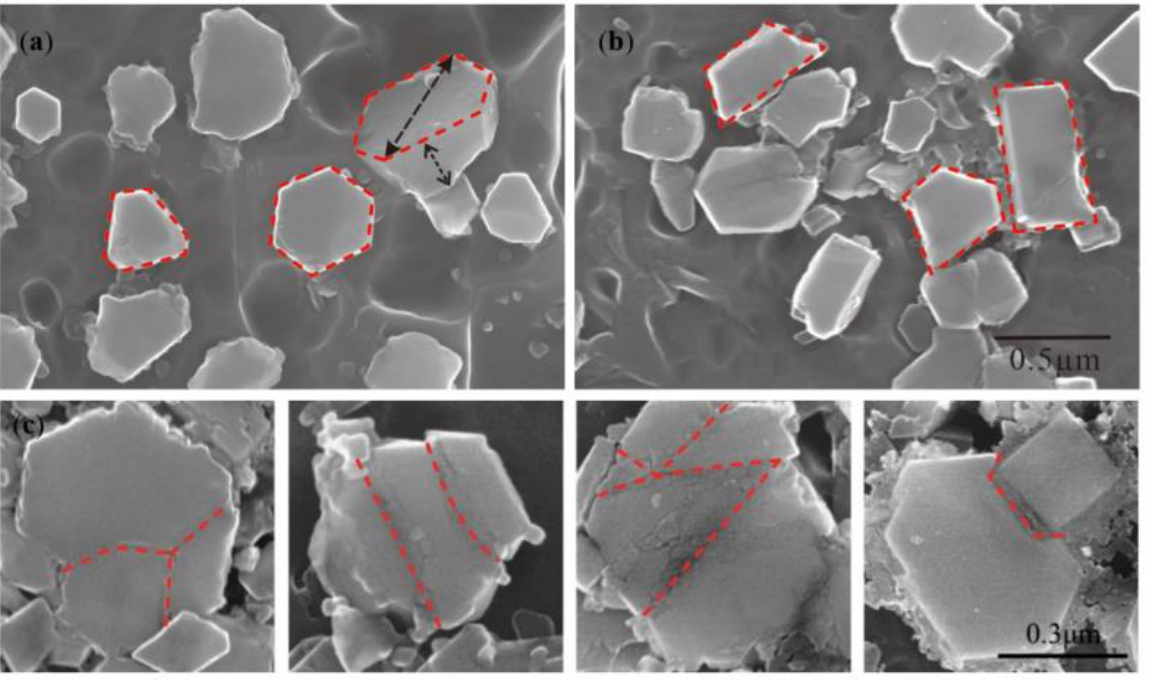
Figure 3. Morphology of TiB 2 in the Al – Ti – B Master Alloy prepared by the halide salt route at 800 °C for 600 s: ( a ) hexagonal TiB 2 ; ( b ) irregular polygon TiB 2 ; ( c ) mutual ”crashing” of fragile TiB 2 .